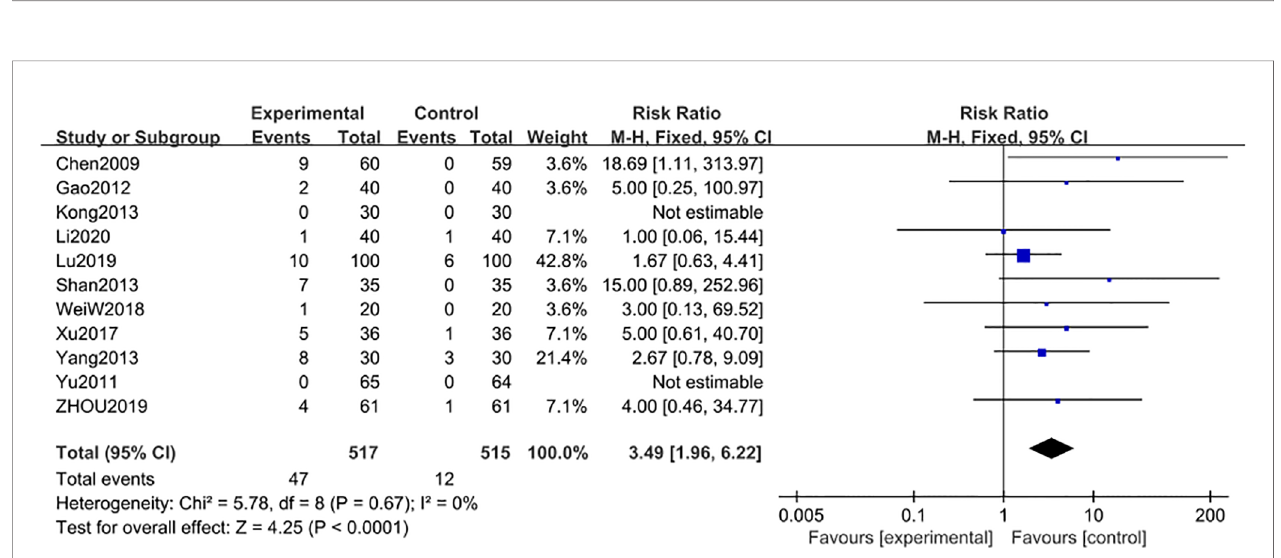
FIGURE 10 | Subgroup analysis of blood creatinine after 6 months: comparison of treatment combined with TG against basic treatment (group 1: range 70-88 m mol/L, group 2: range 94-109 m